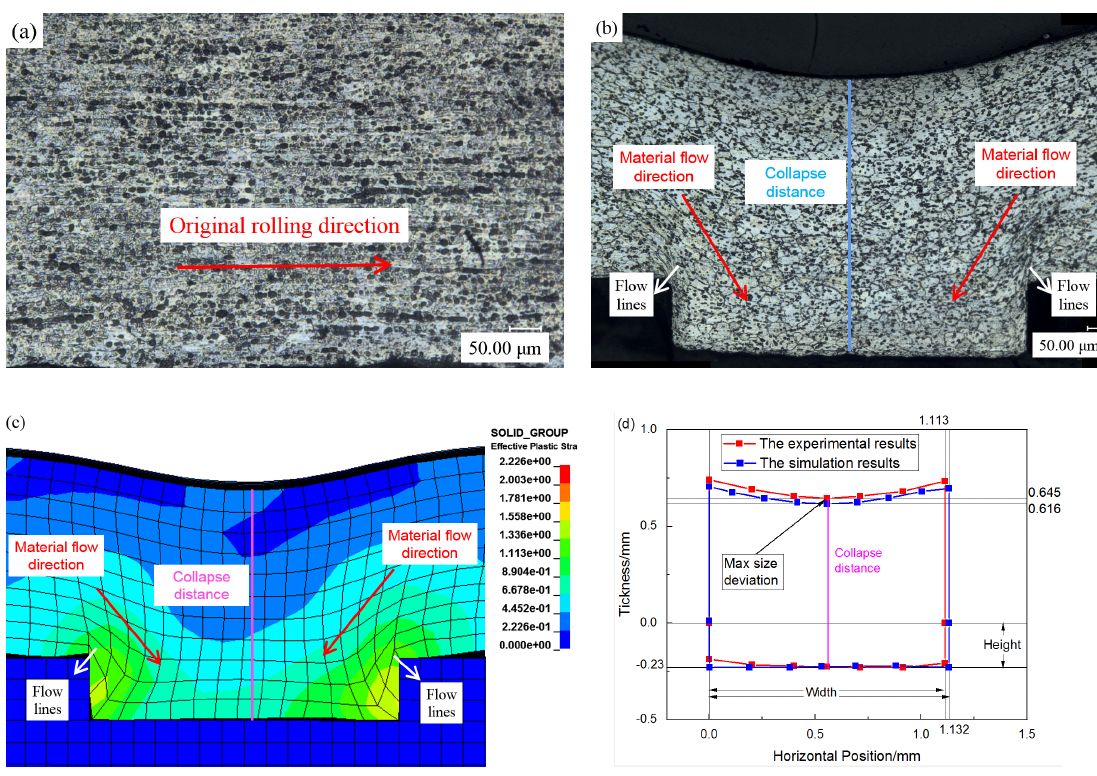
Figure 15. Comparison of local metallographic structure of tubing with simulation results. ( a ) Before Forming. ( b ) After Forming. ( c ) Simulation Results. ( d ) Comparison of the Superimposed